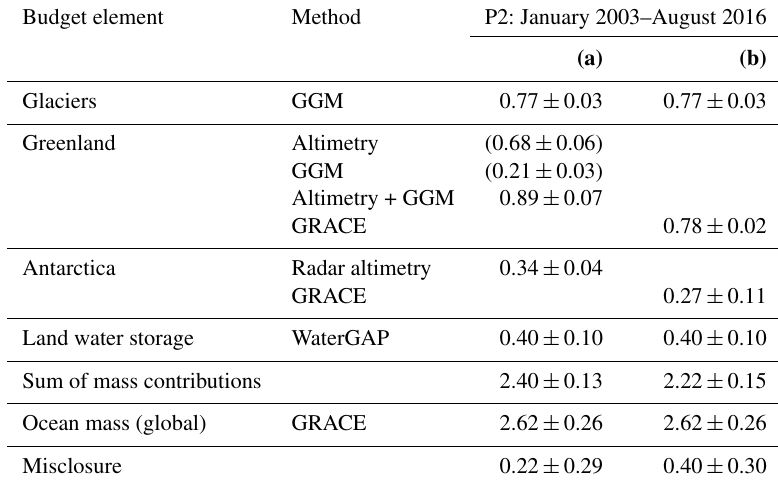
Table 3. Linear trends of the mass budget elements (millimetre equivalent of global mean sea level per year) for the interval P2 and their standard uncertainties. Columns (a) and (b) adopt alternative estimates of the mass contributions from Greenland and Antarctica (as indicated by line labels and footnotes), while adopting the same estimates for the other budget elements.